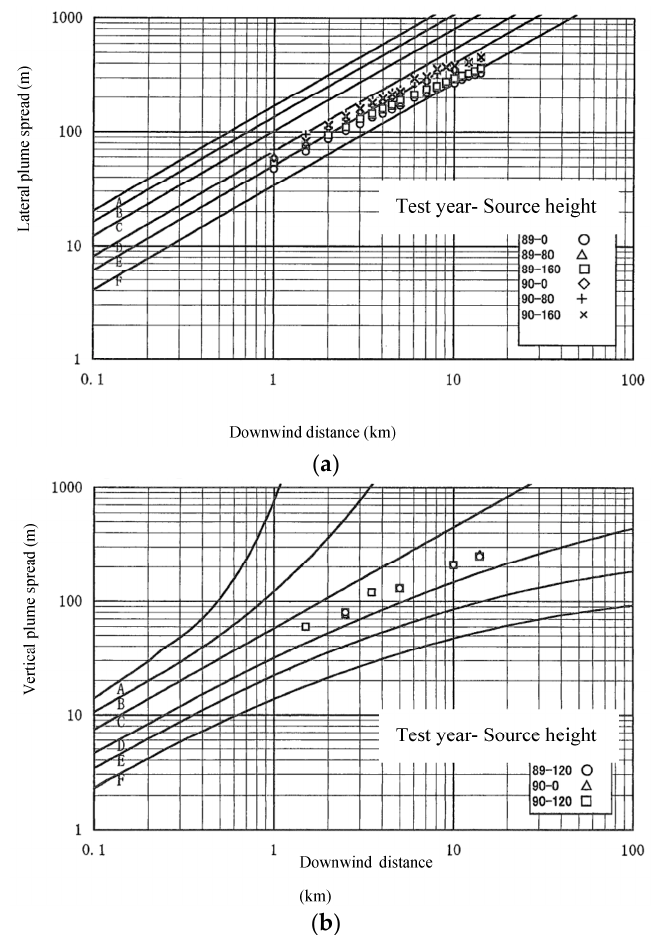
Figure 7. Plume spreads over a flat terrain obtained from wind tunnel simulations [4]. ( a ) Lateral plume spread; ( b ) Vertical plume spread.